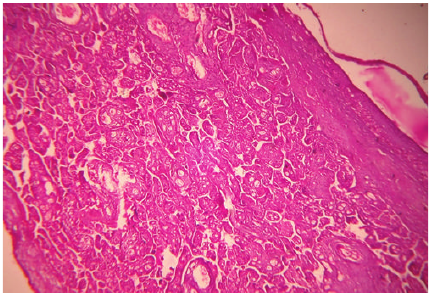
Figure 3: Chorangioma with dilated thin-walled capillaries in the subchorionic tissue: H&E;